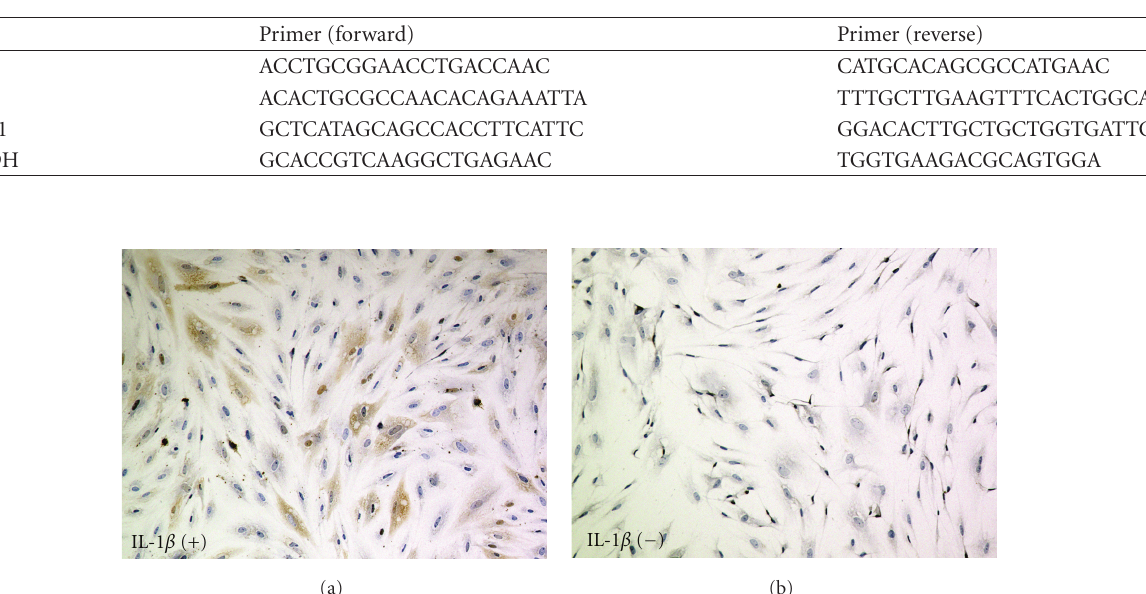
Table 1: Primer sequences.